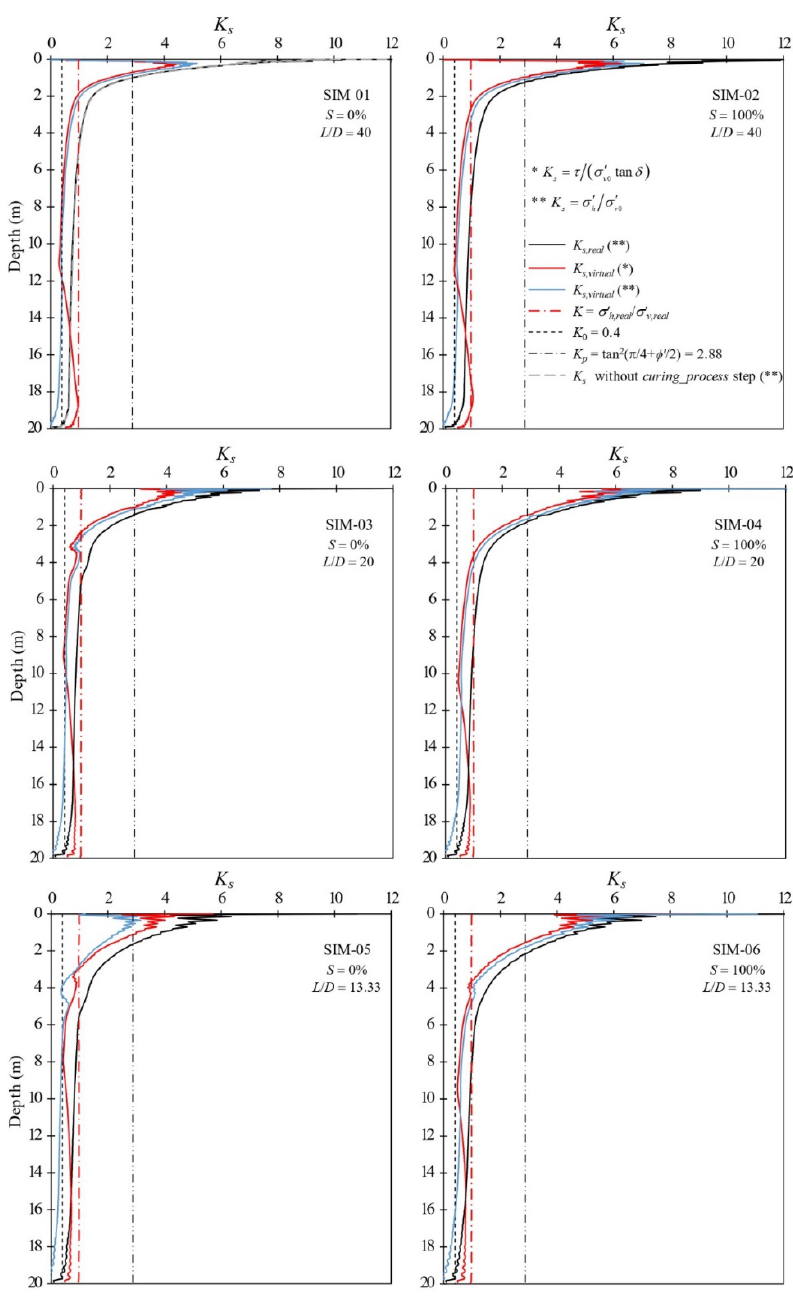
Figure 15. K s distribution along pile